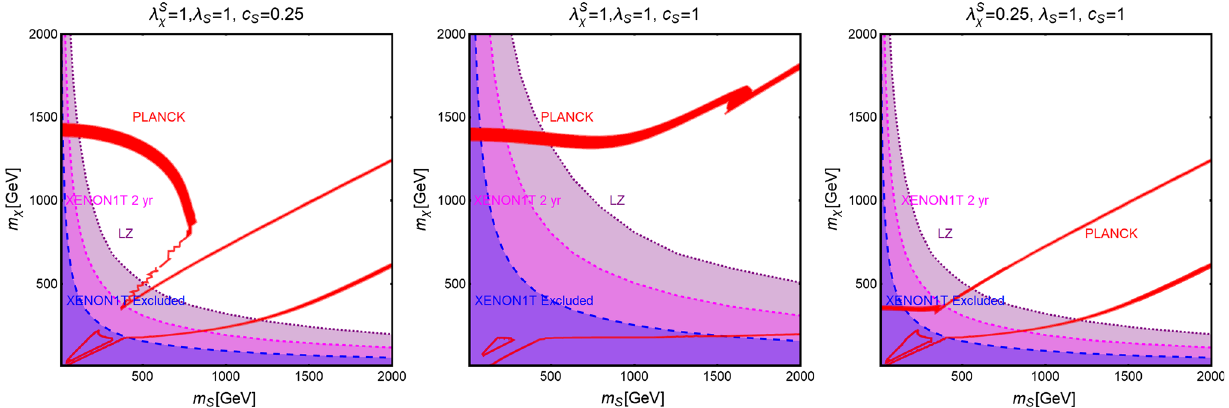
Fig. 9 Combined constrains for a scalar DM with scalar mediator sce- nario in the bi-dimensional plane ( m S , m χ ) for three assignations of the relevant couplings, i.e., (λ S χ , λ S , c S ) = ( 1 , 1 , 0 . 25 ) (left), ( 1 , 1 , 1 ) (middle) and ( 0 . 25 , 1 , 1 ) (right). Here the iso-contours of the correct